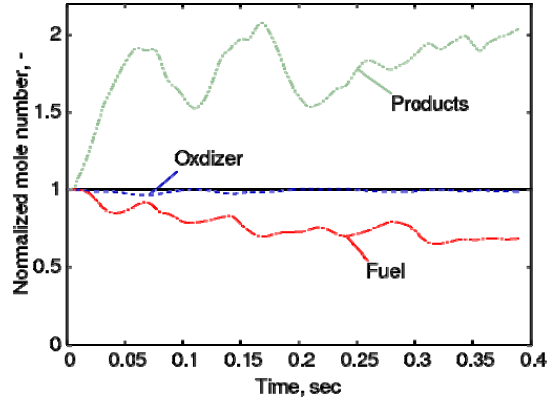
Figure 18. Comparison of mole number normalized by initial values.